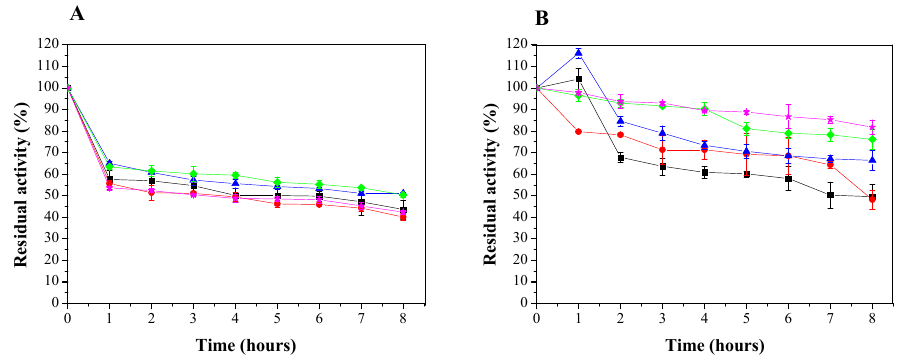
Figure 7. Thermal stability of free ( A ) and immobilized lipase ( B ) at temperatures of 30 °C ( ▲ ), 35 °C ( ♦ ), 40 °C ( ⋆ ), 45 °C ( ∎ ) and 50 °C ( ● ) in 25 mM sodium phosphate ′ buffer, pH 7. The error bars are derived from triplicates.